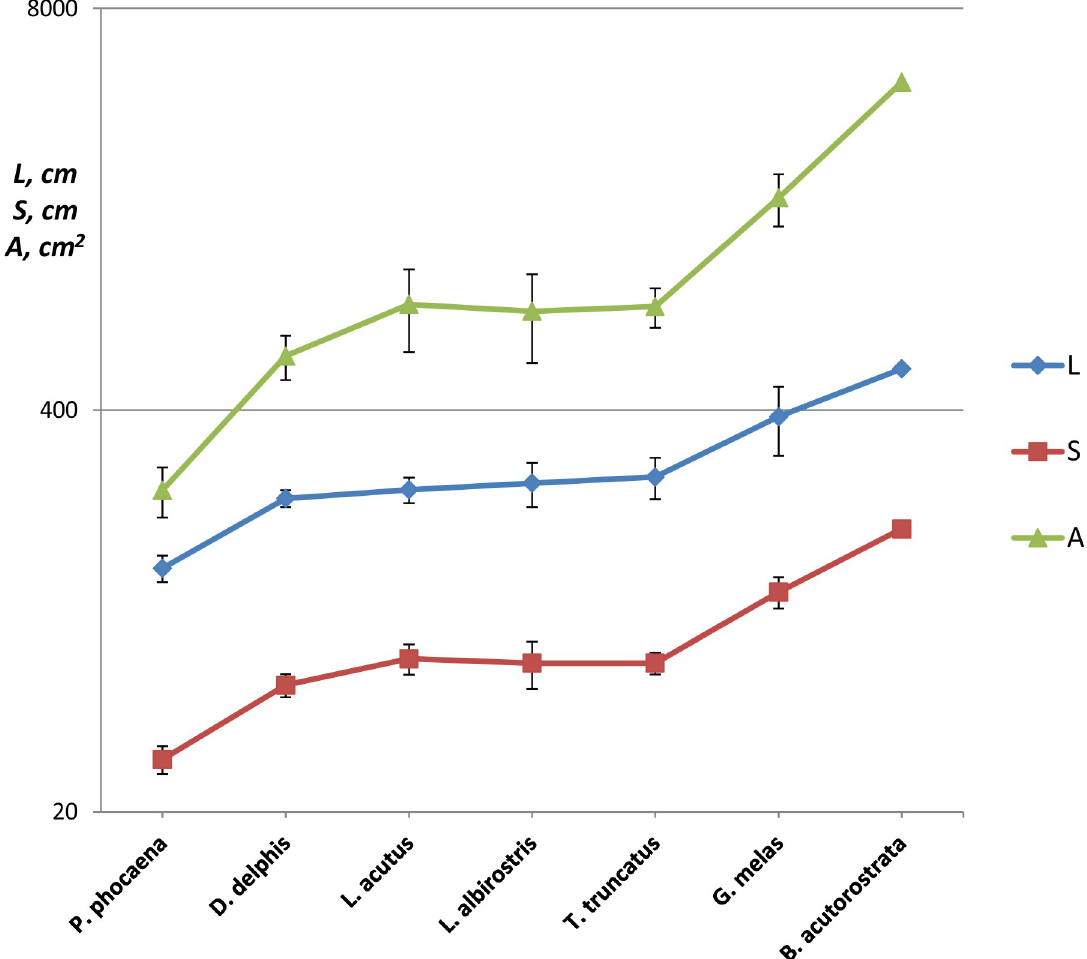
Fig 8. Species-specific differences in the length of the body L cm, span of the fluke S cm and area of the fluke A cm 2 , means ±